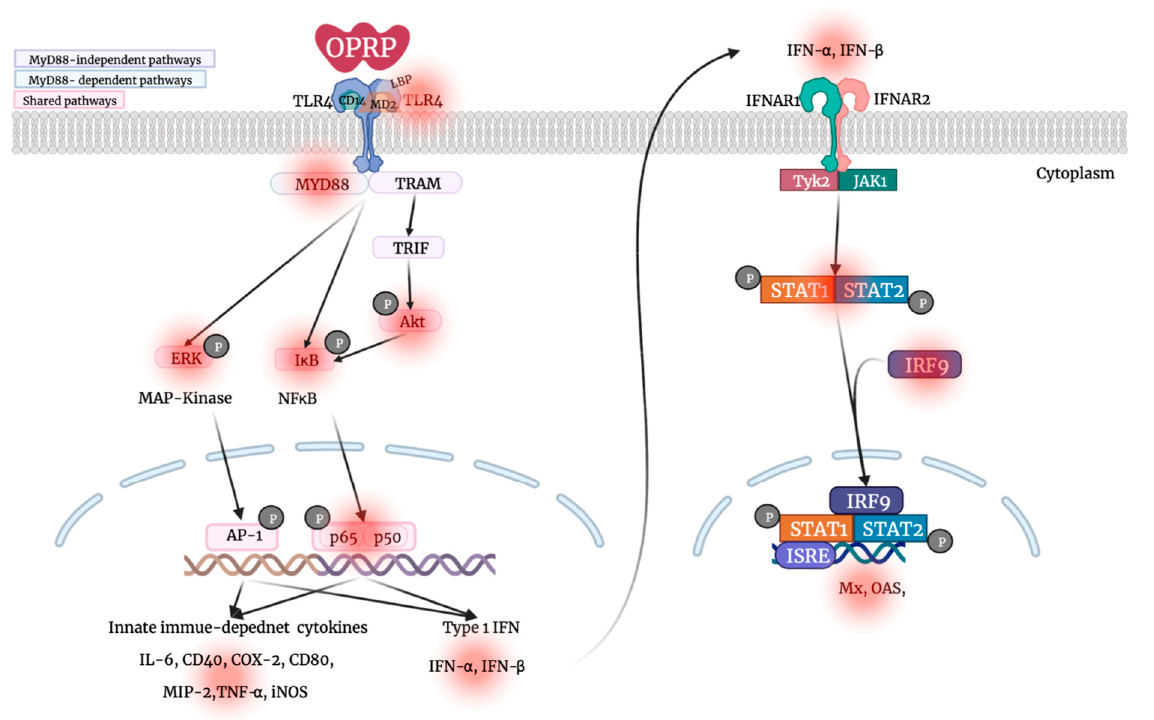
Figure 6. Schematic diagram of the proposed mechanism.